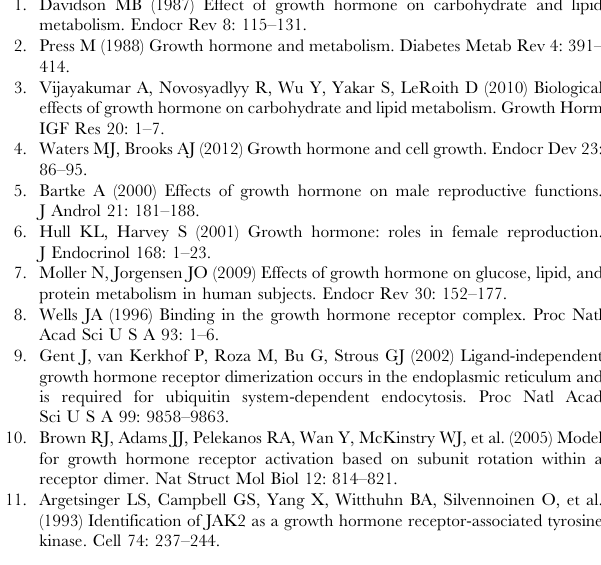
Figure S2 Relationship between predicted novel miR- NAs and known chicken miRNAs. For each novel miRNA, the name is listed in the first line. The sequence of known precursor and its name are described in the second line. The sequence of known miRNA and its name are shown below with ‘*’. Then the sequence of novel miRNA and its name are shown below